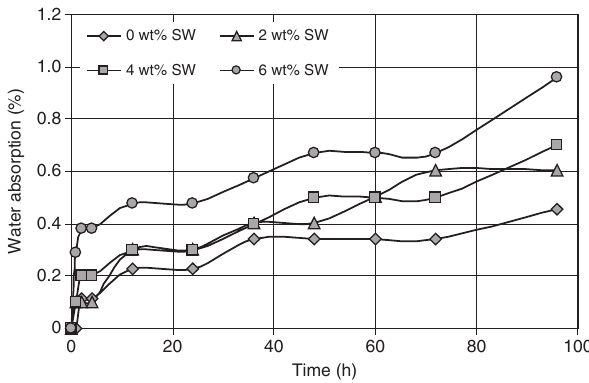
Figure 7 WA as a function of soaking time for different weight percentages of coconut fiber in SW.